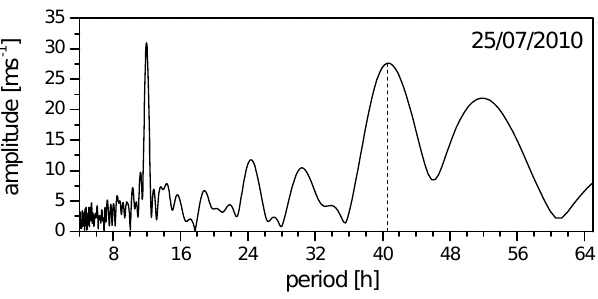
Figure 1. Lomb–Scargle periodogram of the meridional wind for a time interval of 11 days centered on 25 July 2010 (91km altitude). The QTDW period for this day is set to the one with the maximum amplitude between 40 and 60h, illustrated by the vertical dotted line.